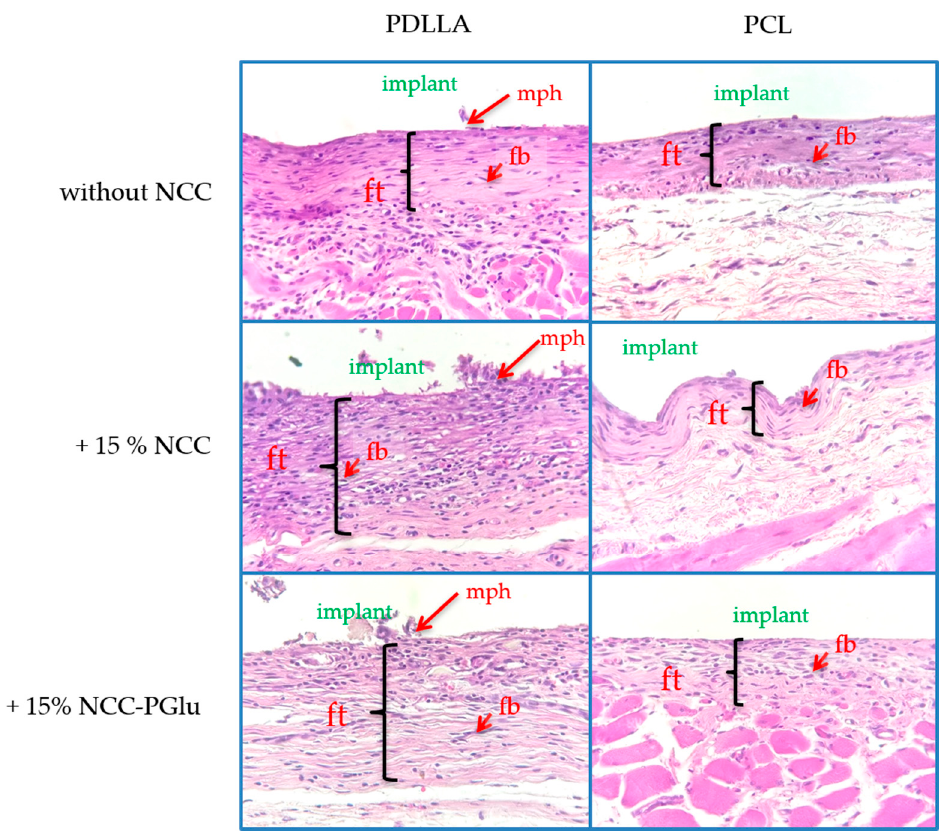
Figure 8. Representative histological sections (×40) after four weeks of subcutaneous implantation. (Abbreviations: mph – macrophage, fb – fibroblast, ft – fibrous tissue.).